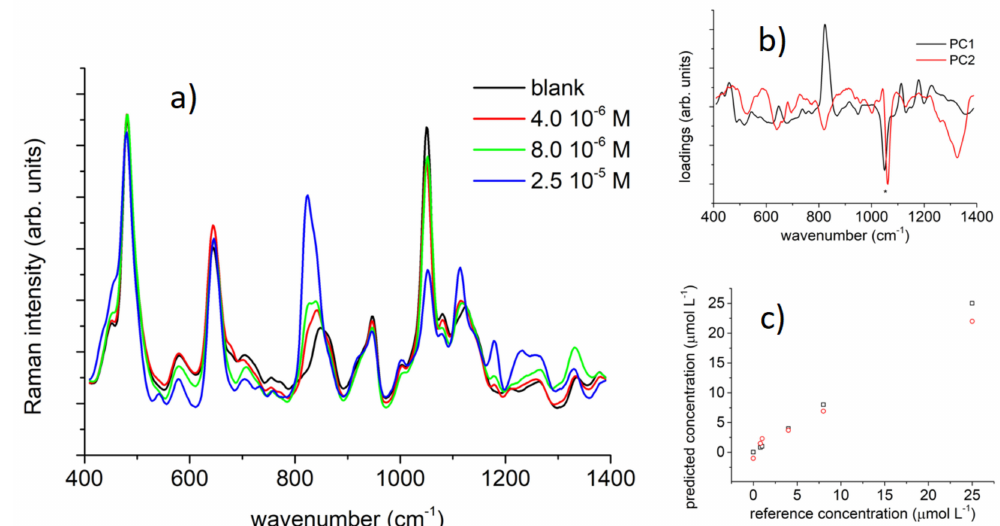
Figure 5. Relevant SERS data for BPA and the multivariate analysis. ( a ) BPA SERS spectra as a function of the nominal BPA molar concentration (SNV data transformation and smoothing applied). ( b ) Loadings for the first two components in the PCA analysis on the BPA SERS data (full spectrum). PC1 and PC2 were carrying the 82 and 9% of the spectral variance, respectively. ( c ) Predicted (black square) and validated (red circle) concentration of BPA in model samples vs. reference analytical concentration as obtained by the partial least square (PLS) regression analysis (4 factors model) on SERS data (full